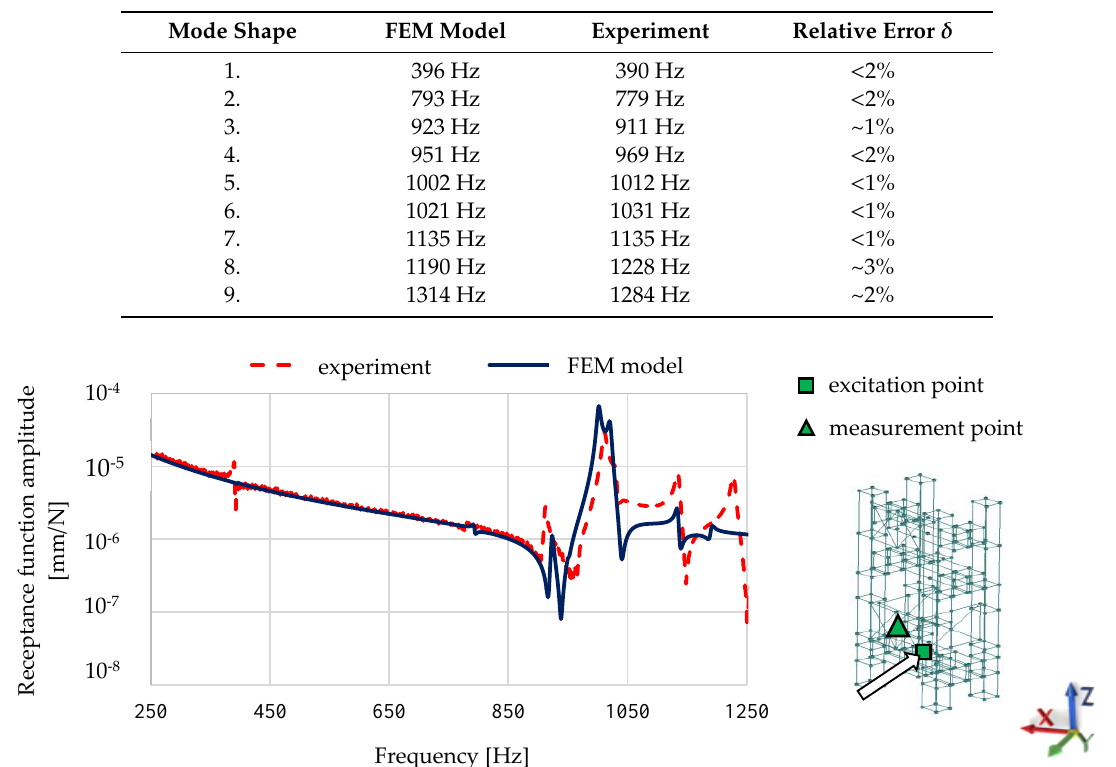
Figure 14. Comparison of the receptance functions calculated and experimentally determined for the complex steel–polymer concrete frame.